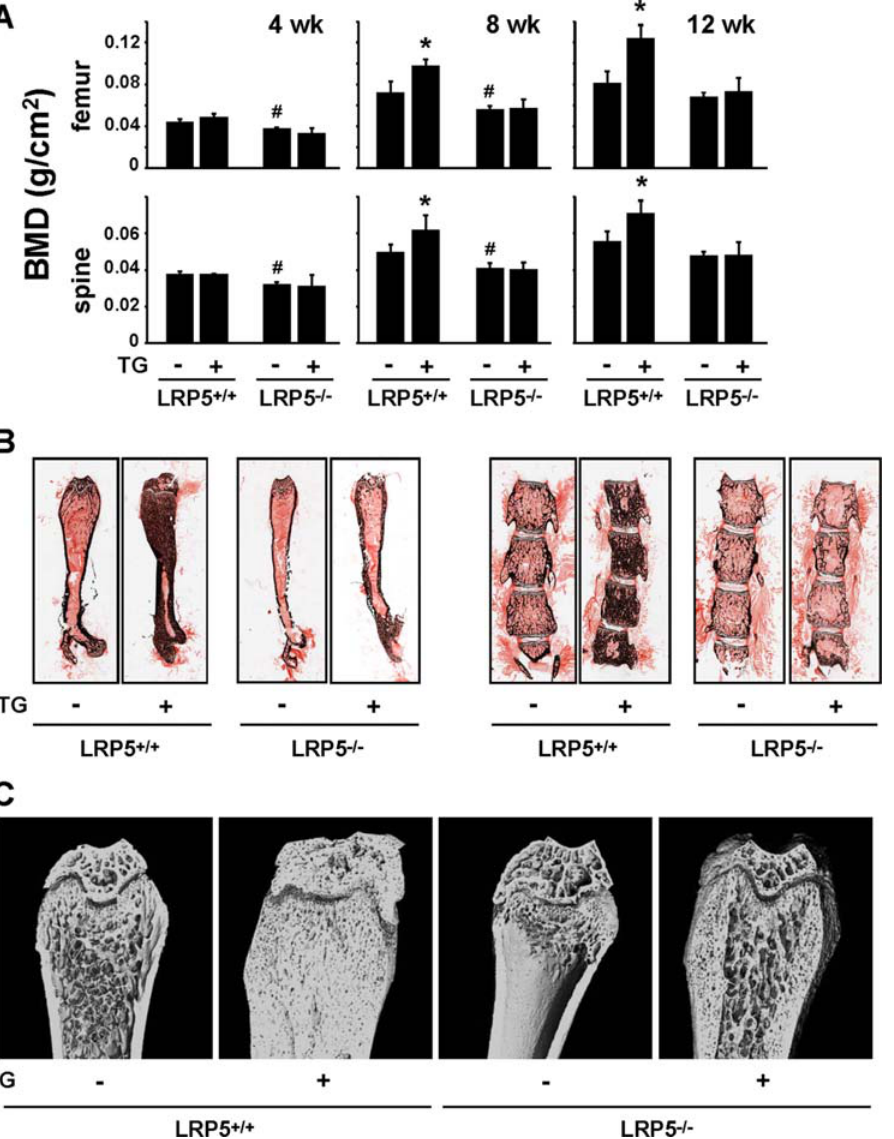
Figure 5. The High Bone Mass Phenotype of the DMP1-caPTHR1 Mice is Ameliorated in Mice Lacking the Wnt Co-Receptor LRP5. (A) Serial analysis of BMD in the femur and spine of LRP5 + / + and LRP 2 / 2 mice, with and without the DMP1-caPTHR1 transgene. Both sexes were included. Bars represent the mean 6 SD of 3–5 mice/group. * p , 0.05 vs. LRP5 + / + mice without the transgene. # p , 0.05 vs. LRP + / + mice without the transgene. (B) Von Kossa staining of femurs and lumbar vertebrae of 12-week-old LRP5 + / + and LRP 2 / 2 mice, with and without the DMP1-caPTHR1 transgene. (C) High resolution micro-CT scans of distal femora from LRP5 + / + and LRP 2 / 2 mice, with and without the DMP1-caPTHR1 transgene.